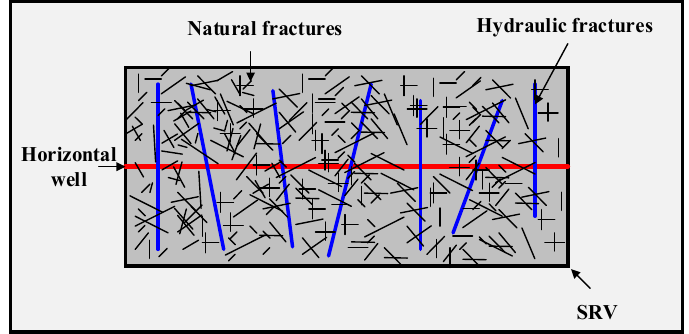
Figure 1. Schematic of a shale gas reservoir after hydraulic fracturing.